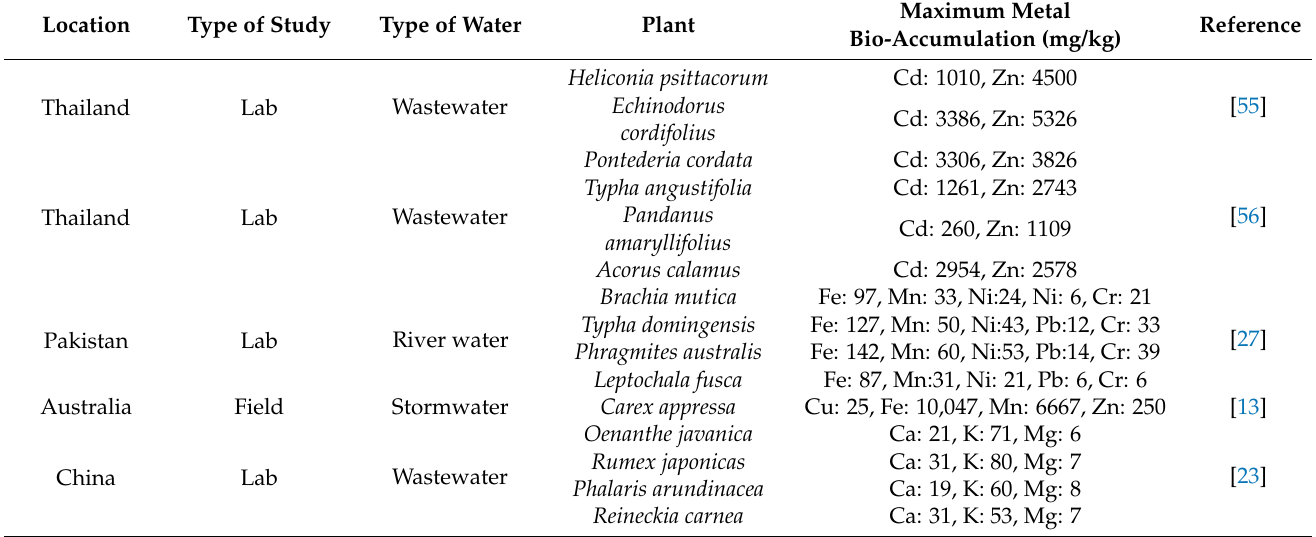
Table 5. Maximum metal bio-accumulation within plant tissue in previous